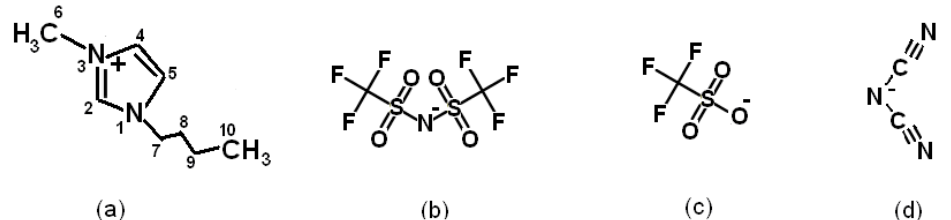
Figure 1. Structural formula of ( a ) a 1-butyl-3-methylimidazolium cation [BMIm] + , as well as ( b ) bis(trifluoromethylsulfonyl)imide [NTf 2 ] − , ( c ) trifluoromethanesulfonate [OTf] − , and ( d ) dicyanamide [DCA] − anions.